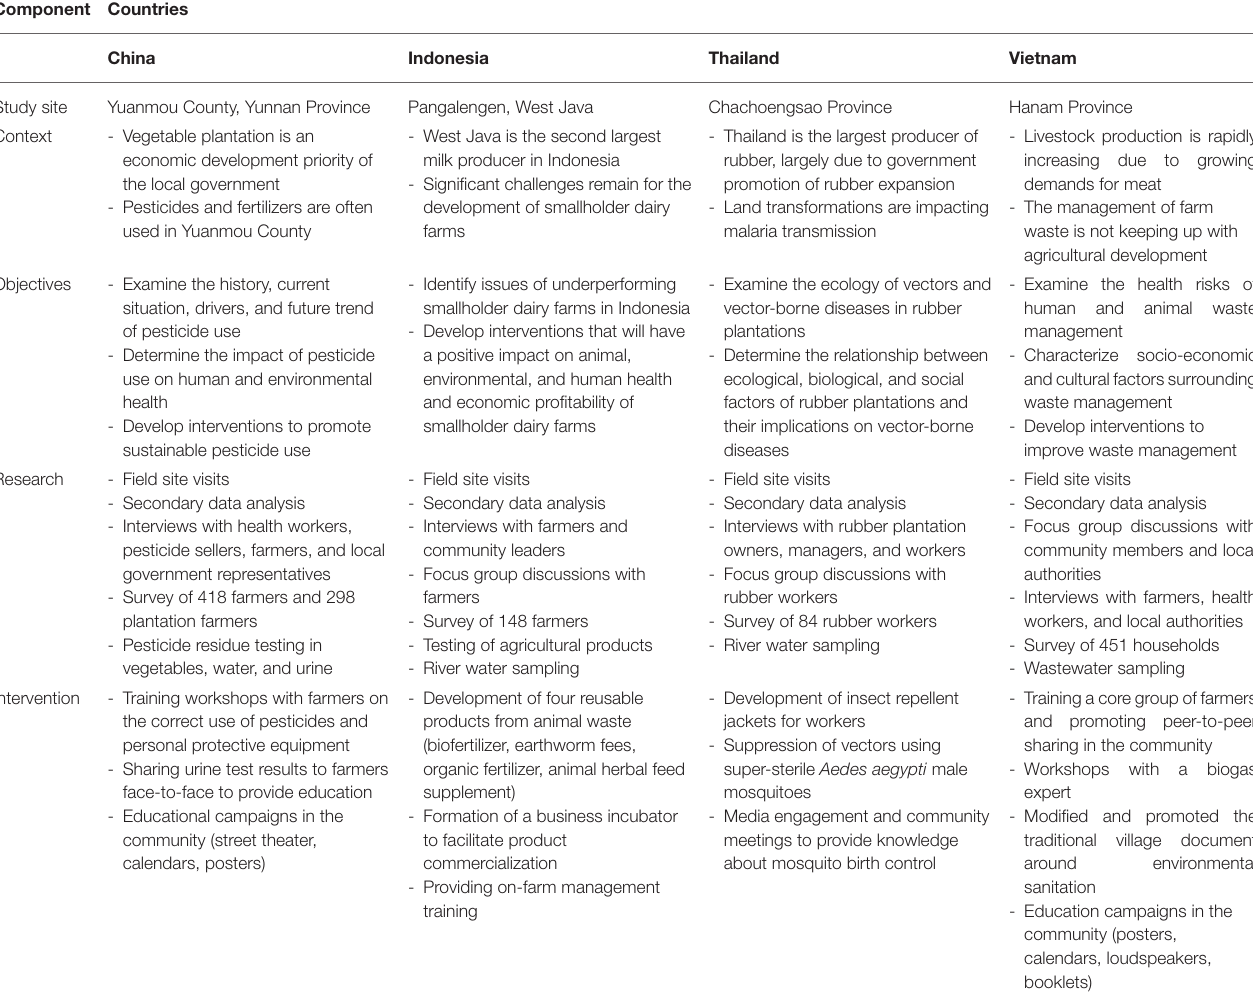
TABLE 1 | Overview of Ecohealth study sites, objectives, research, and interventions in China, Indonesia, Thailand, and Vietnam. Component